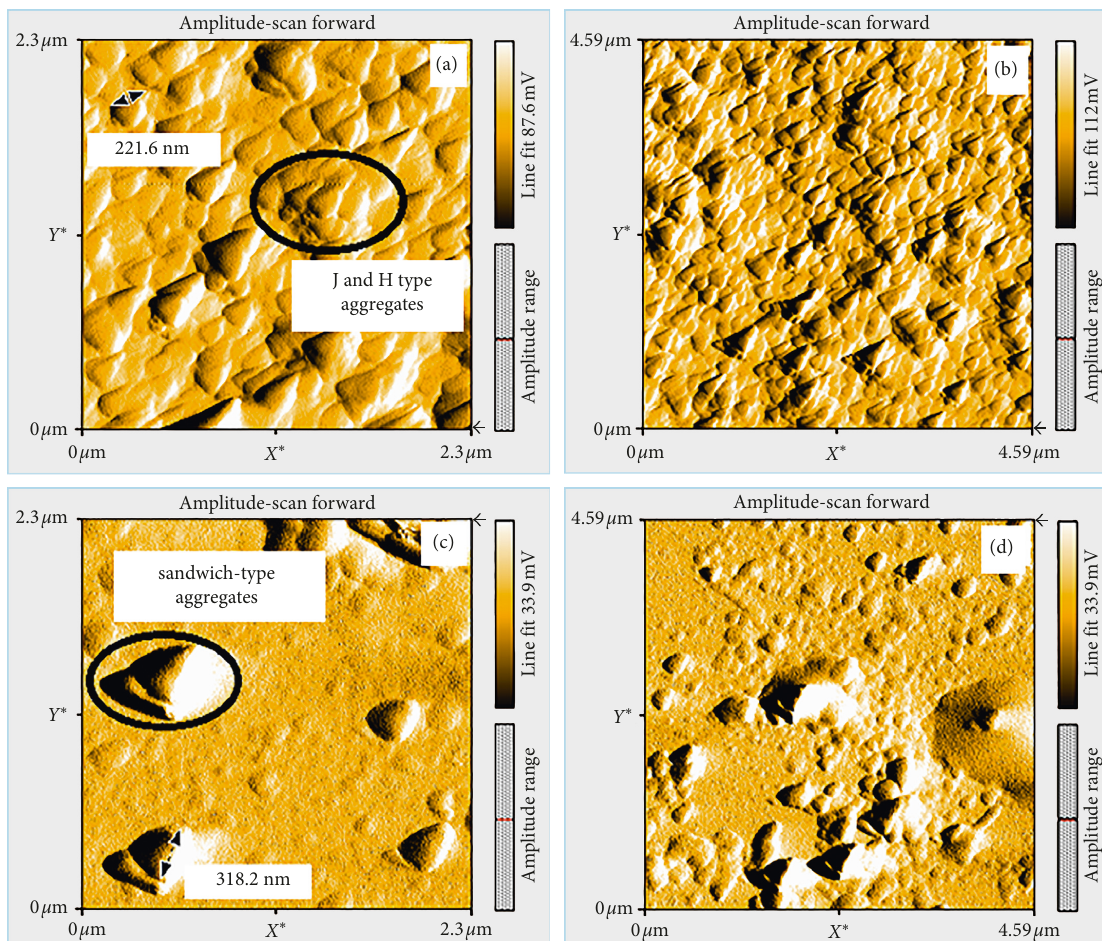
Figure 9: AFM images for the MnTTPCl/n-Au hybrid before (a, b) and after treatment with β -carotene (c,